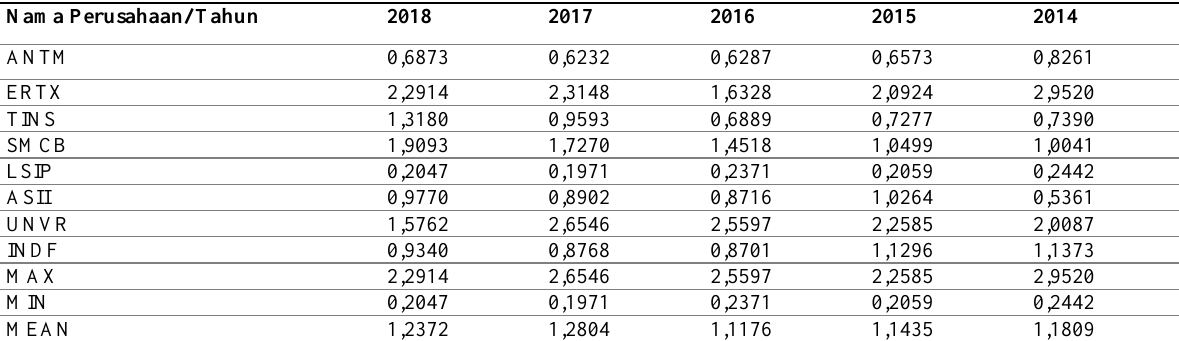
Table 4: Value of Funding Decisions (DER) 2014-2018